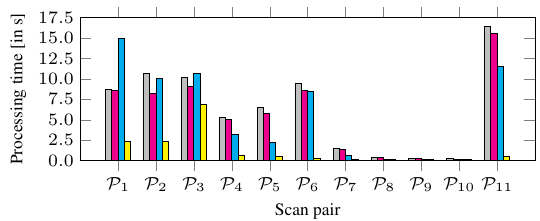
Figure 8. Mean processing times required for the coarse regis- tration of scan pairs P i = {S i , S i +1 } when applying no reliabil- ity check (gray) and reliability checks w.r.t. intensity (magenta), range reliability (cyan) or planarity